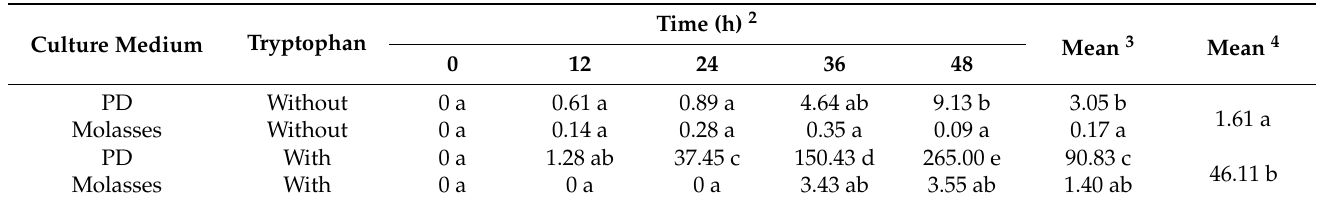
Table 3. Statistical results of IAA production ( µ g mL − 1 ) by C. vulgaris in potato dextrose broth (PD) and molasses, with or without tryptophan, by Tukey ´ s test ( p < 0.05) 1